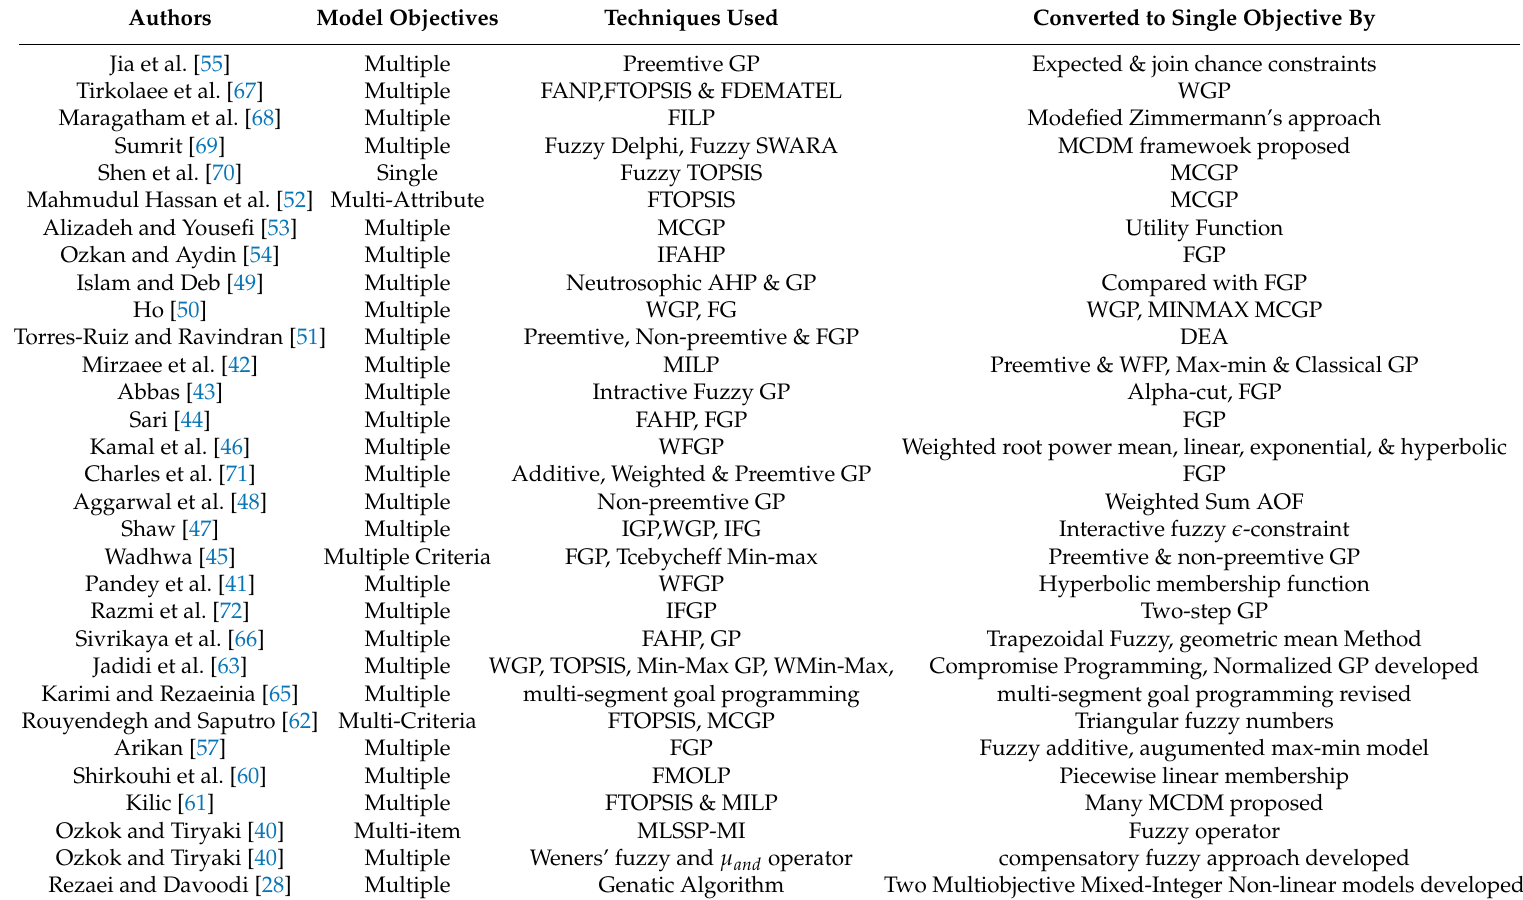
Table 1. Summary of Literature